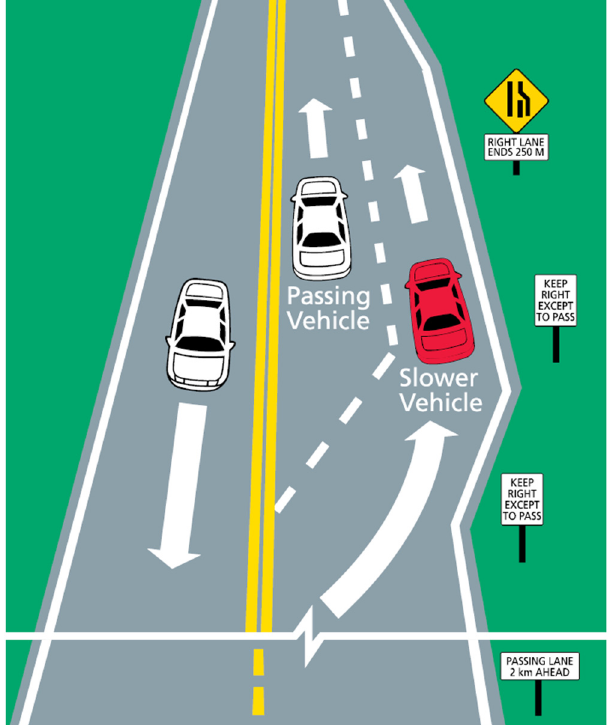
Figure 1. A drawing showing a passing lane layout [16].